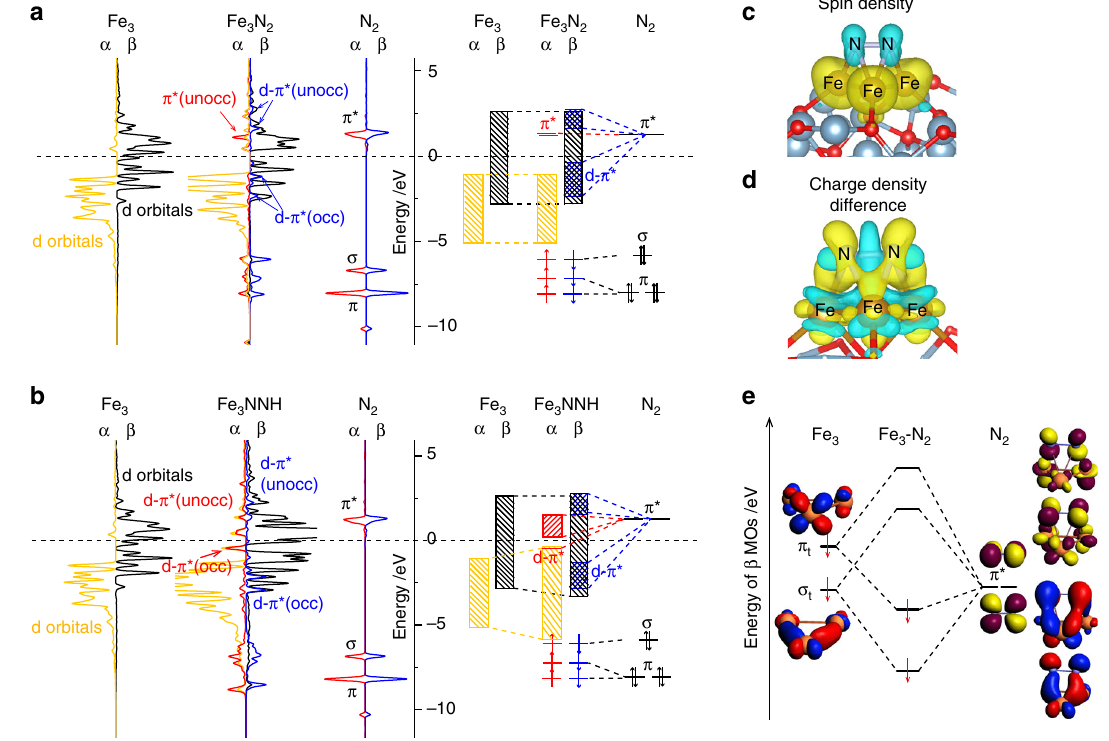
Fig. 5 Electronic structure analysis. a Projected electronic densities of states (pDOS) and schematic illustrations of 3d orbitals of Fe 3 cluster on θ - Al 2 O 3 (010), 2p-orbitals of the N 2 gas molecule, and their interaction within Fe 3 N 2 / θ -Al 2 O 3 (010) of μ 3 − η 2 : η 1 η 1 con fi guration. b pDOS and schematic illustrations for the Fe 3 NNH/ θ -Al 2 O 3 (010) case. c Spin density of Fe 3 N 2 / θ -Al 2 O 3 (010). (yellow stands for spin up and cyan for spin down) d Charge density differences ( δ ρ = ρ A + B − ρ A − ρ B ) of N 2 adsorption on Fe 3 / θ -Al 2 O 3 (010) (cyan stands for holes and yellow for electrons). e The major interactions and energy levels of the scalar relativistic Kohn – Sham β -spin MOs of isolated Fe 3 N 2 with correlation to the orbitals from Fe 3 and N 2